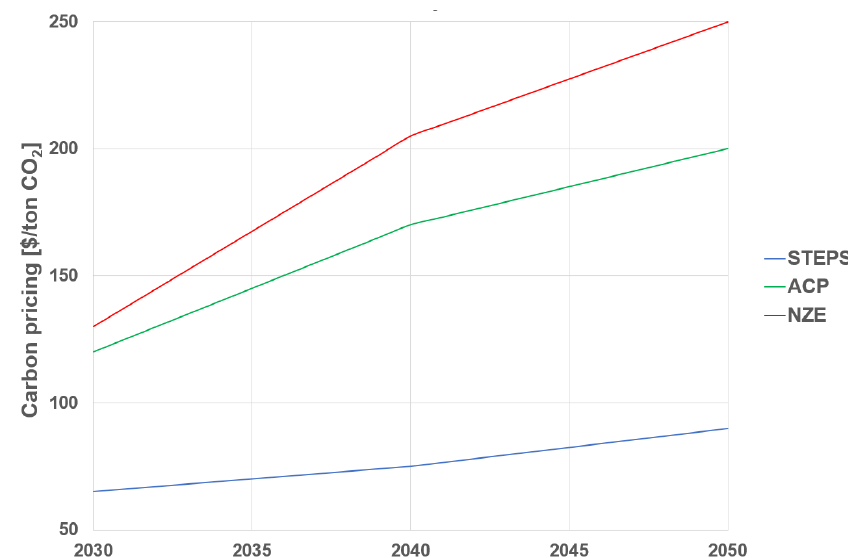
Figure 4. Carbon pricing scenarios.